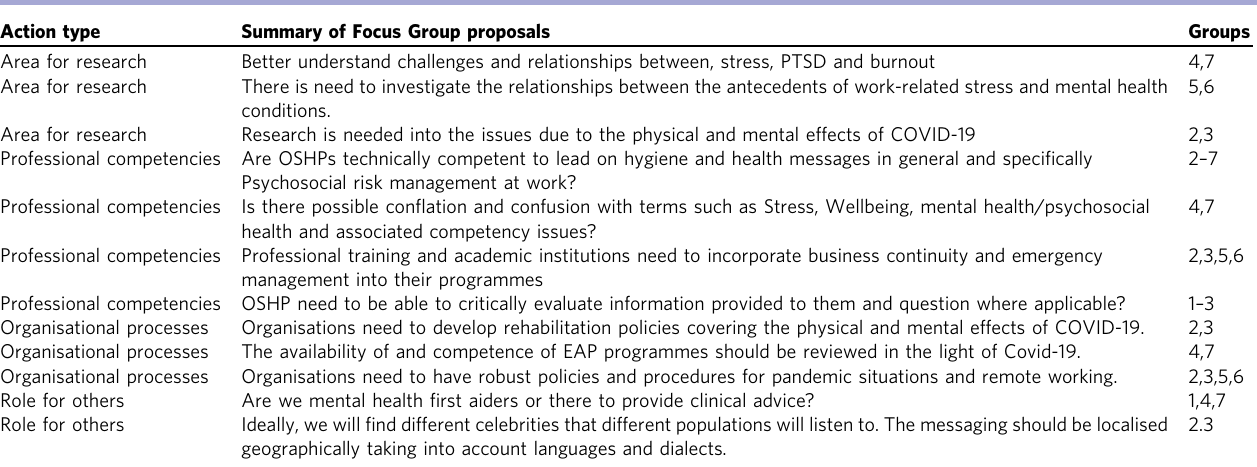
Table 6 Summary of results — research competencies and other fi